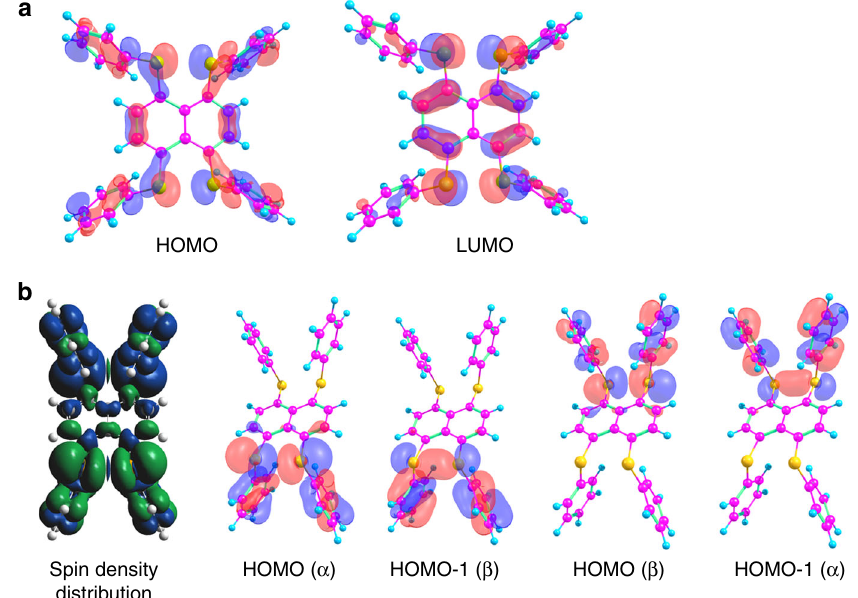
Fig. 5 Molecular orbitals and spin density distribution. a Frontier molecular orbitals of 1 2 + . b The spin density distribution and some molecular orbitals of 2 2 +